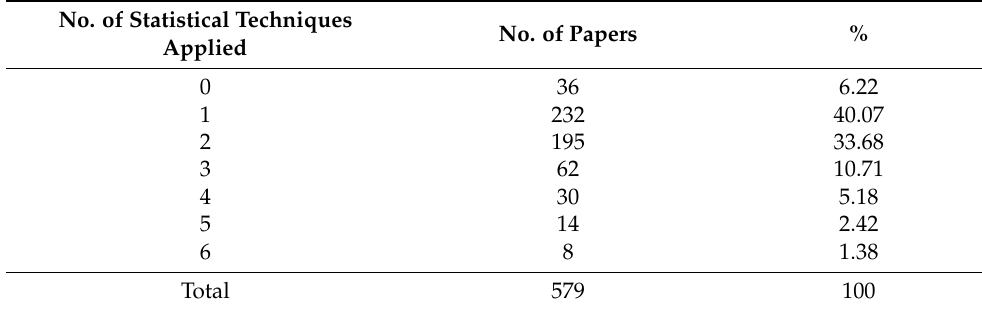
Table 10. Papers by the number of statistical techniques applied.